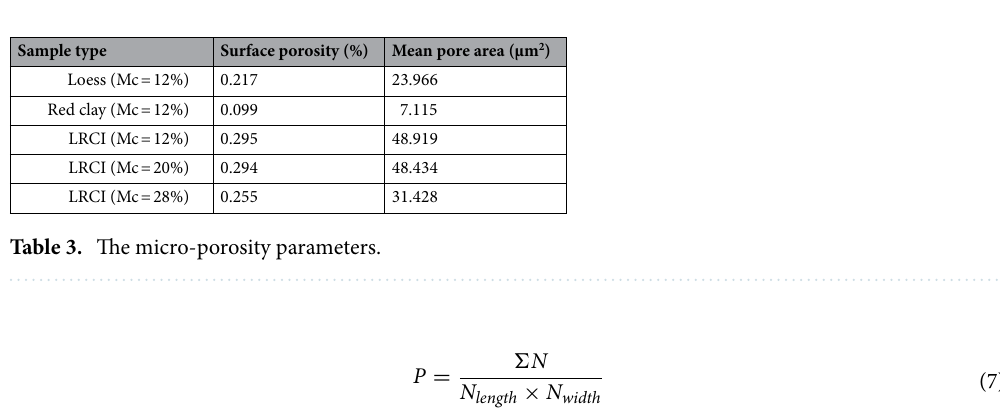
Figure 14. The micro-porosity parameters. ( a ) Surface porosity, ( b ) mean pore area.